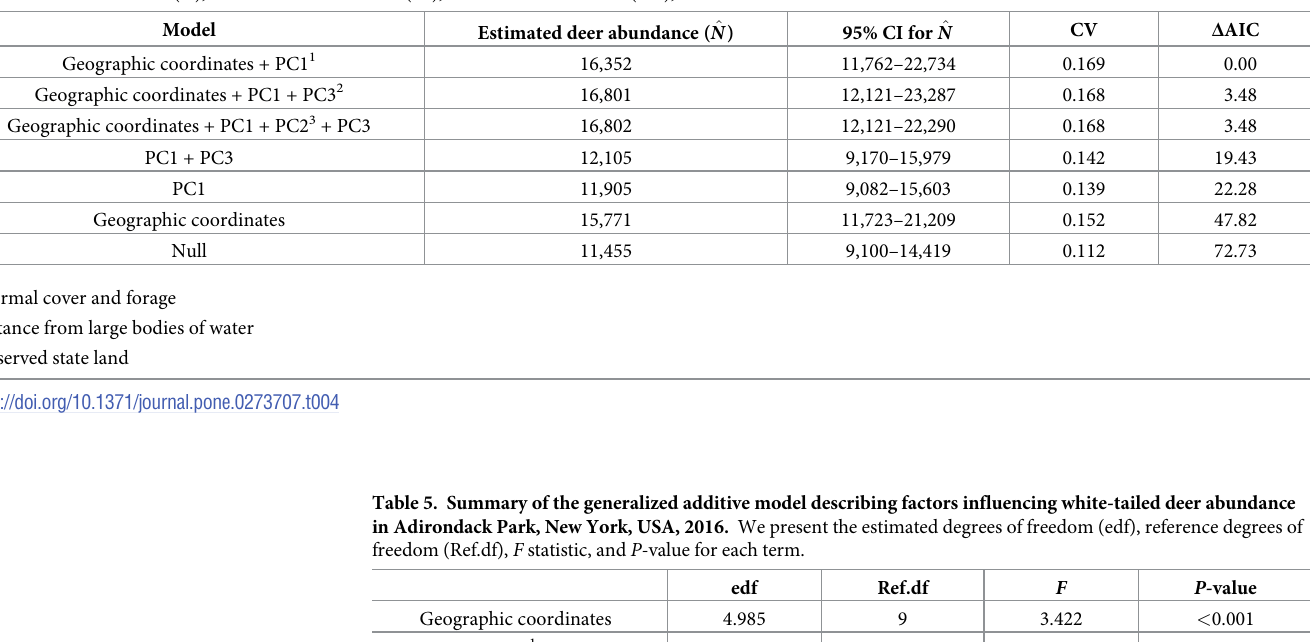
Table 4. Top GAM models and the null model for white-tailed deer abundances in the Adirondack Park, New York, USA. For each area and period, we provide the estimated deer abundance (N), 95% confidence interval (CI), coefficient of variation (CV), and Δ AIC.